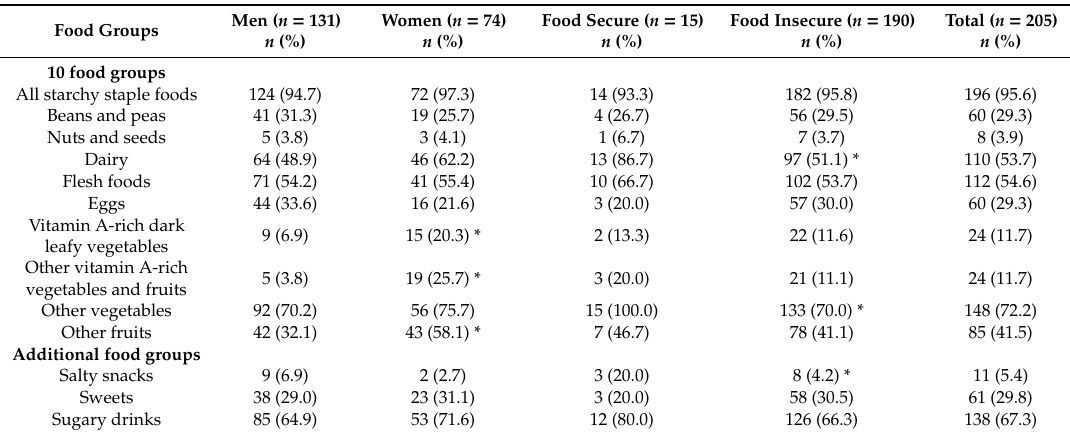
Table 3. Frequency of food group consumption in the past 24 h among asylum seekers living in reception centers in southeastern Norway by gender and food security status ( n =